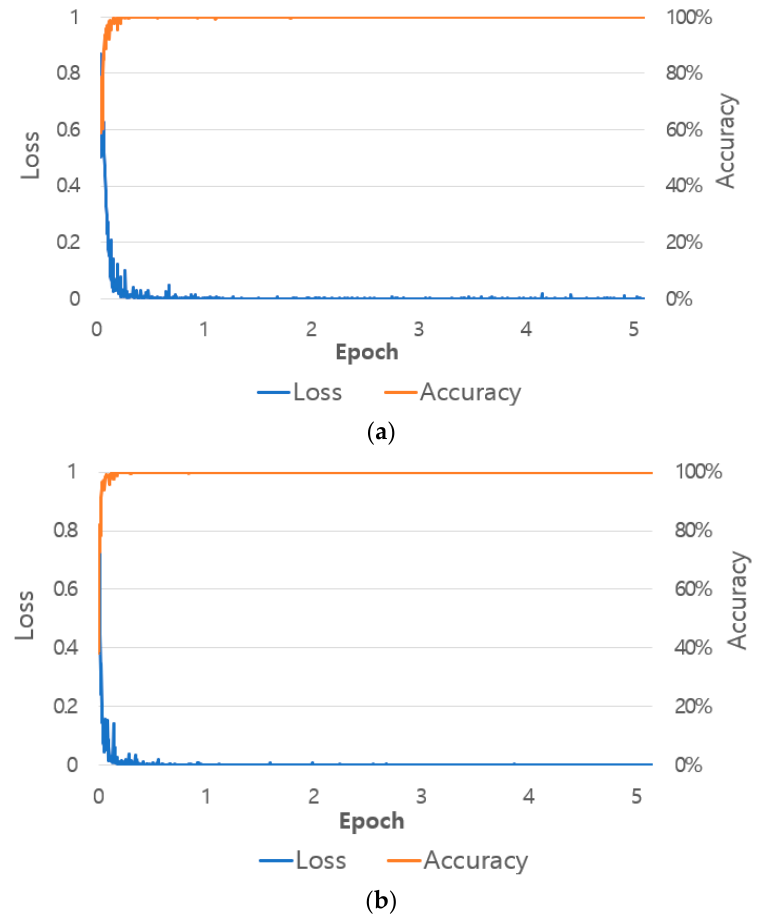
Figure 13. Training accuracy and loss graphs with shallow CNN in ( a ) the 1st fold validation, and ( b ) the 2nd fold validation.